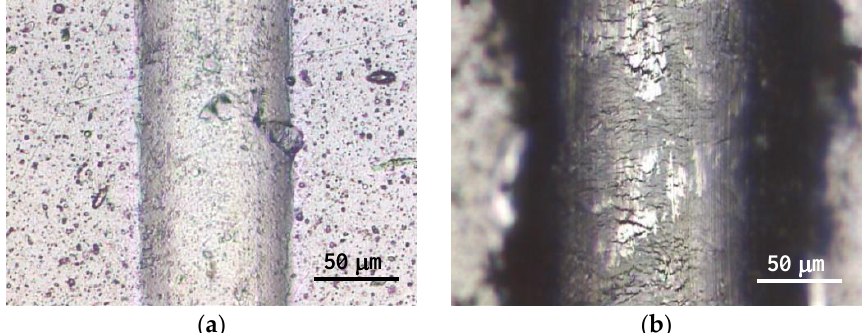
Figure 12. Scratch-failure images of the AlCrN coating: ( a ) L C1 , ( b ) L C2 .